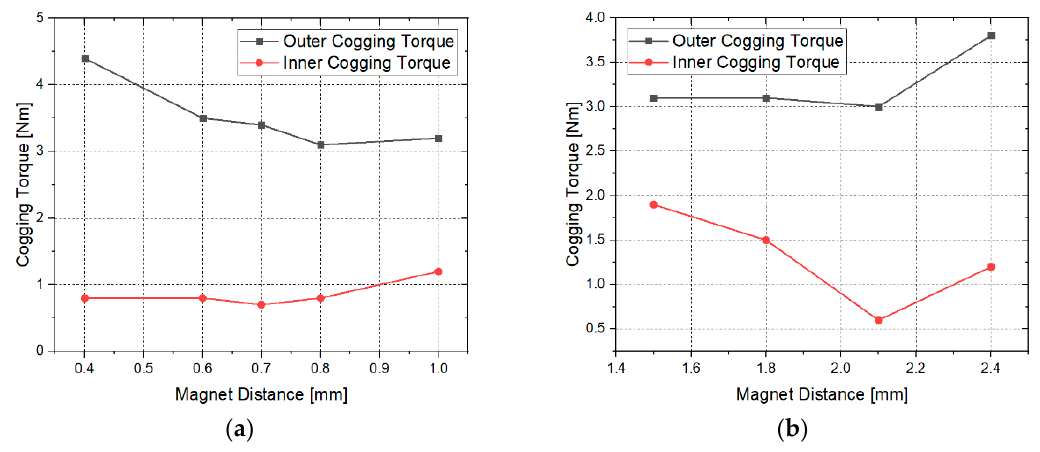
Figure 6. Cogging torque according to the distance between magnet and stator of dual rotor. ( a ) Distance between magnet and stator of outer rotor; ( b ) Distance between magnet and stator of inner rotor.